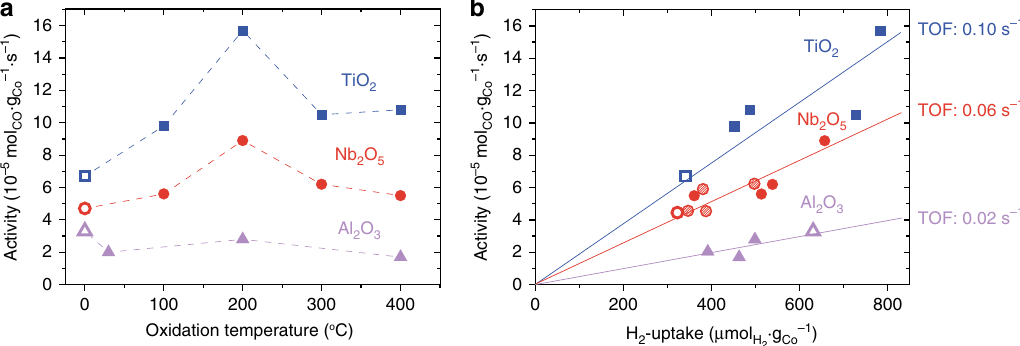
Fig. 5 The effect of the ROR treatment on the catalytic activity in the Fischer – Tropsch synthesis. FT was performed at 20 bar, 220 °C, H 2 /CO = 2 V / V , GHSV = 1000 – 13000 h − 1 , time-on-stream = 90 – 100 h, CO conv. = 15 – 34% (TiO 2 ), 17 – 25% (Nb 2 O 5 ), and 8 – 12% (Al 2 O 3 ). a Cobalt-weight-based catalytic activity of Co/TiO 2 (blue squares), Co/Nb 2 O 5 (red circles), and Co/Al 2 O 3 (violet triangles) after various reduction – oxidation – reduction treatments. The activity of the pristine samples after reduction at 350 °C (R-samples, open symbols) is included at 0 on the x -axis. b Cobalt-weight-based activity as a function of hydrogen uptake for the R-samples (open symbols) and the samples after reduction at 350 °C followed by oxidation between 30 and 400 °C and reduction at either 220 °C ( fi lled symbols) or at 250 °C (dashed symbols); values for the turnover frequencies (TOF) have been calculated from the slopes of the lines